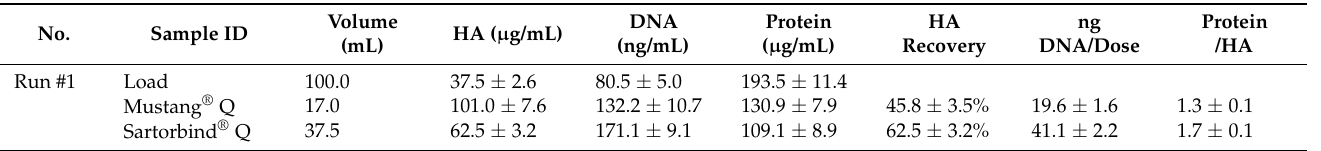
Table 4. Different performance of Mustang ® Q and Sartobind ® Q in ion exchange chromatography step using the supernatant from Run #1.